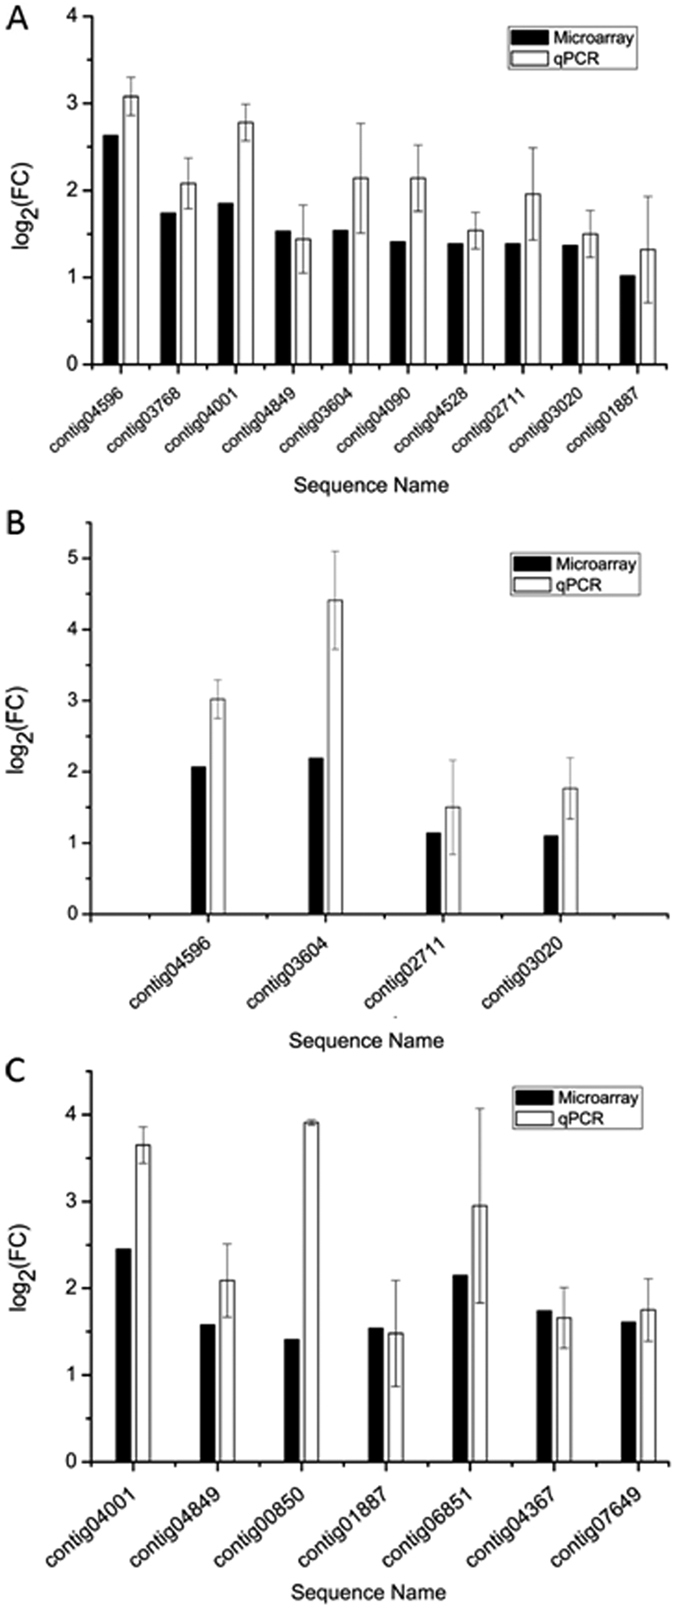
Microarray validation of selected putative detoxification and digestive genes overexpressed in the 3 transcriptomic comparisons.(A) Larvae fed upon green olives vs. larvae fed upon artificial diet. (B) Larvae fed upon black olives vs. larvae fed upon artificial diet. (C) Larvae fed upon green olives vs. larvae fed upon black olives. Error bars represent the standard deviation of four biological replicates. Microarray data are also presented. Contig04596: serine protease; contig03768: serine protease; contig04001: UDP-glucosyltransferase; contig04849: serine protease; contig03604: cytochrome P450; contig04090: serine protease; contig04528: serine protease; contig02711: serine protease; contig03020: N-acetyltransferase; contig01887: peptidase; contig00850: metalloprotease; contig06851: lysozyme; contig04367: serine protease; contig07649: protease.